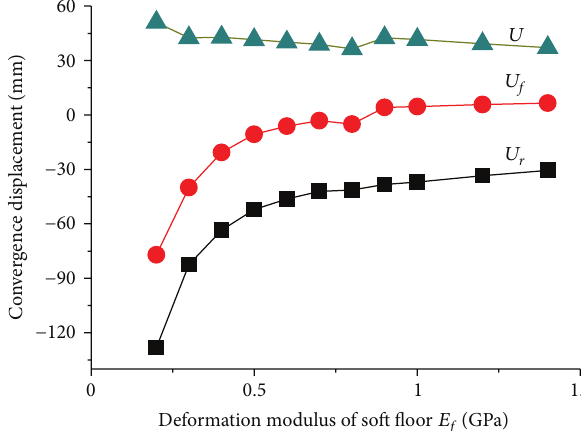
Figure 9: Changes of tunnel displacements with deformation modulus of soft